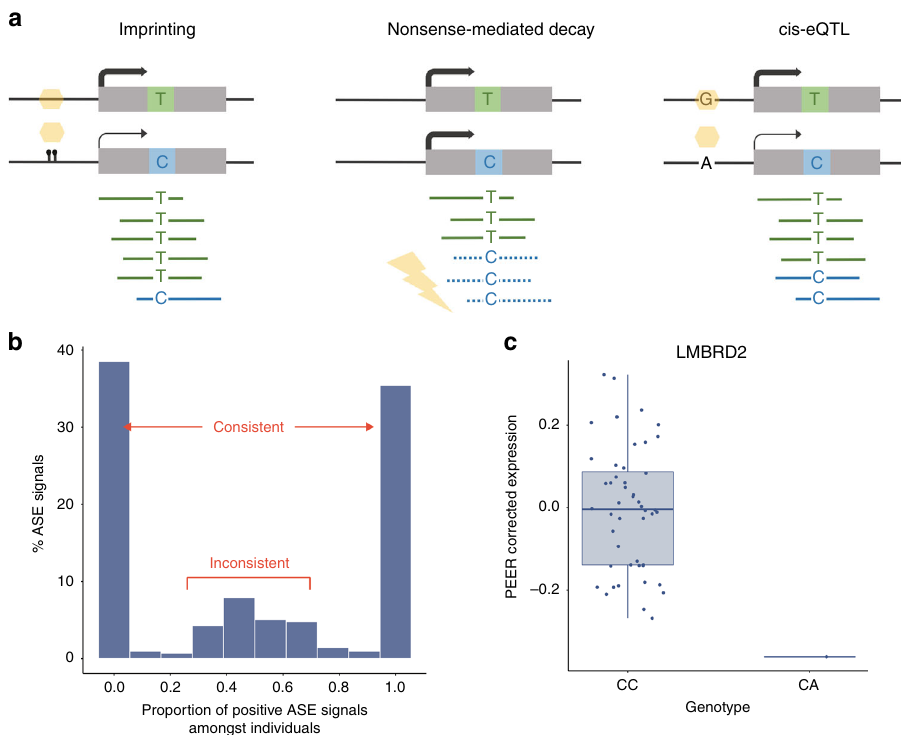
Fig. 6 Allele-speci fi c expression provides evidence of dosage compensation. a Overview of the mechanisms by which allele-speci fi c expression can arise. Allele-speci fi c expression can arise through epigenetic effects (e.g., imprinting), heterozygous mutations triggering nonsense-mediated decay of transcripts, and regulation by (for example) a cis-regulatory variant (cis-eQTL). b The majority of allele-speci fi c expression signals passing FDR < 0.05 produced unidirectional signals (0 or 1) and were considered consistent. Inconsistent ASE signals (those that were not unidirectional in ≥ 10 individuals) were found only in known imprinted genes, thus providing additional validation of our ASE signals. c Comparison of LMBRD2 expression in putamen from one individual heterozygous for a rare stop gain mutation (CA) in the gene versus all other individuals (CC) revealed a signi fi cant reduction in LMBRD2 expression, implying effective nonsense-mediated decay. Data presented using Tukey-style box plots. Source data are provided as a Source Data fi